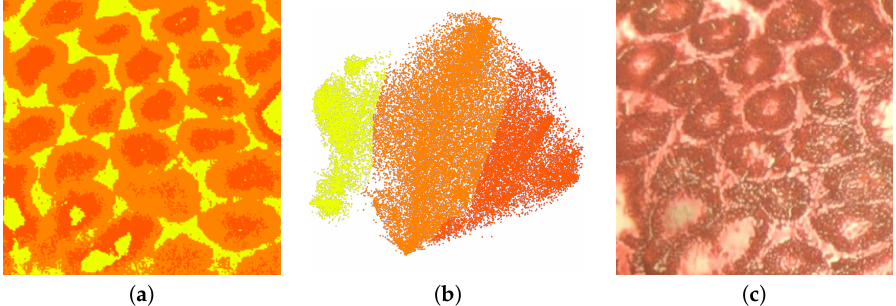
Figure 16. Rat testis data set [9]: Interactive selection of clusters in non-linear embedding ( b ) reveals image regions ( a ) close to ground truth ( c ).